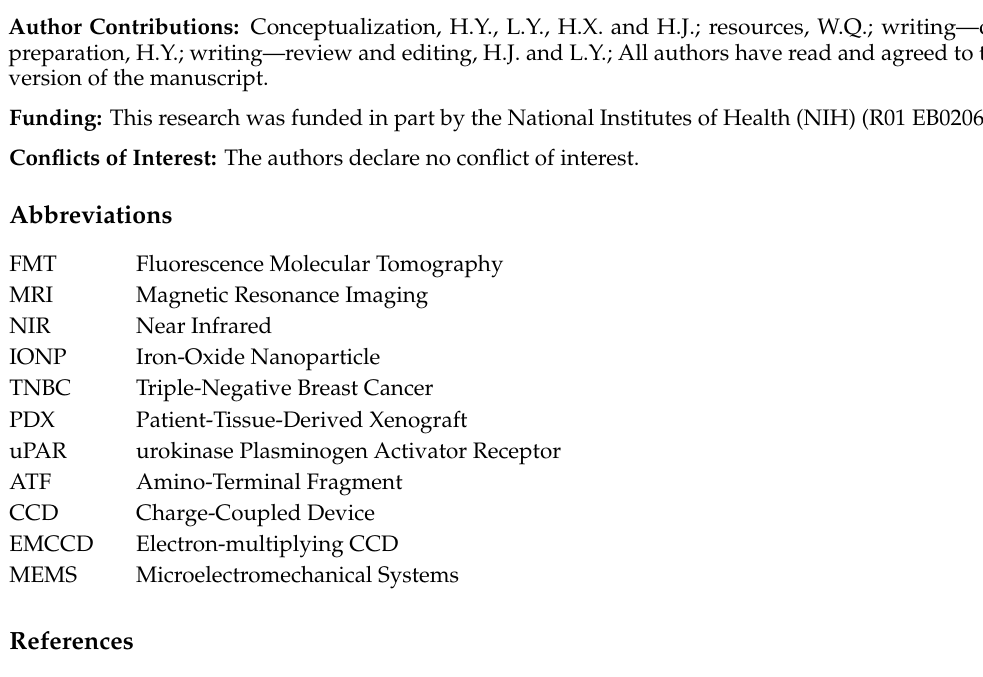
Figure 7. Schematic of the production of receptor targeted imaging nanoparticles.